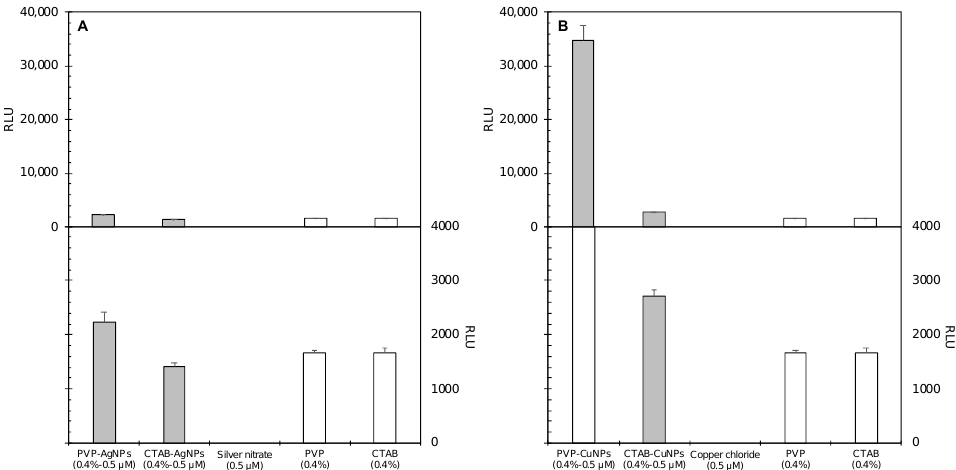
Figure 3. Effects of nanoparticle systems on ROS generation by BEAS-2B mammalian cells treated with two exposure concentrations, namely 0.5 µM (data shown) and 1.0 µM (data not shown). The top panels ( A , B ) show the same data as the bottom panels, respectively, but at different scales. The top panel shows that the PVP-CuNP is drastically larger than the others, while the bottom panel allows comparison between the smaller values. ( A ) Relative luminescence units (RLU) versus silver treatment type. ( B ) RLU versus copper treatment type. Error bars depict one standard deviation from the mean. The assay was validated using menadione as a positive control for ROS production in mammalian cells; its RLU value was 84,500.